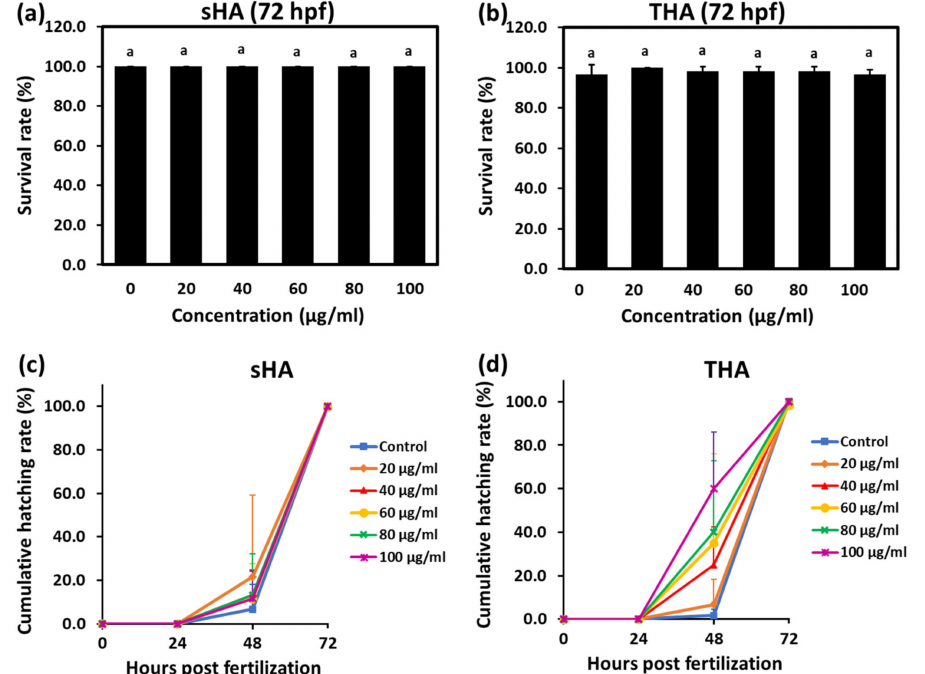
Figure 10. Survival rates for zebrafish embryos exposed to different concentrations ( µ g/mL) of sHA ( a ) and THA ( b ) at 72 h post-fertilization (hpf). Cumulative hatching rate of zebrafish embryos exposed to different concentrations of sHA ( c ) and THA ( d ) at 24, 48, and 72 hpf. The results are presented as mean ± SE (n = 3). a: p < 0.01 versus control.